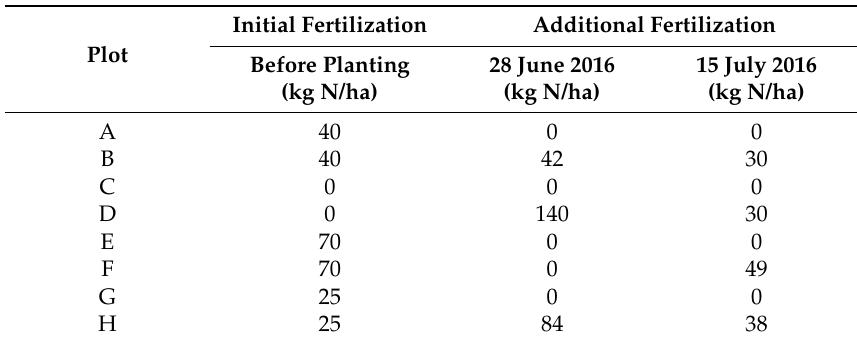
Table 1. Overview of the nitrogen (N) fertilization applied to the various plots within the potato experimental field in 2016. Initial Fertilization Additional Fertilization Plot Before Planting 28 June 2016 15 July 2016 (kg N/ha) (kg N/ha) (kg